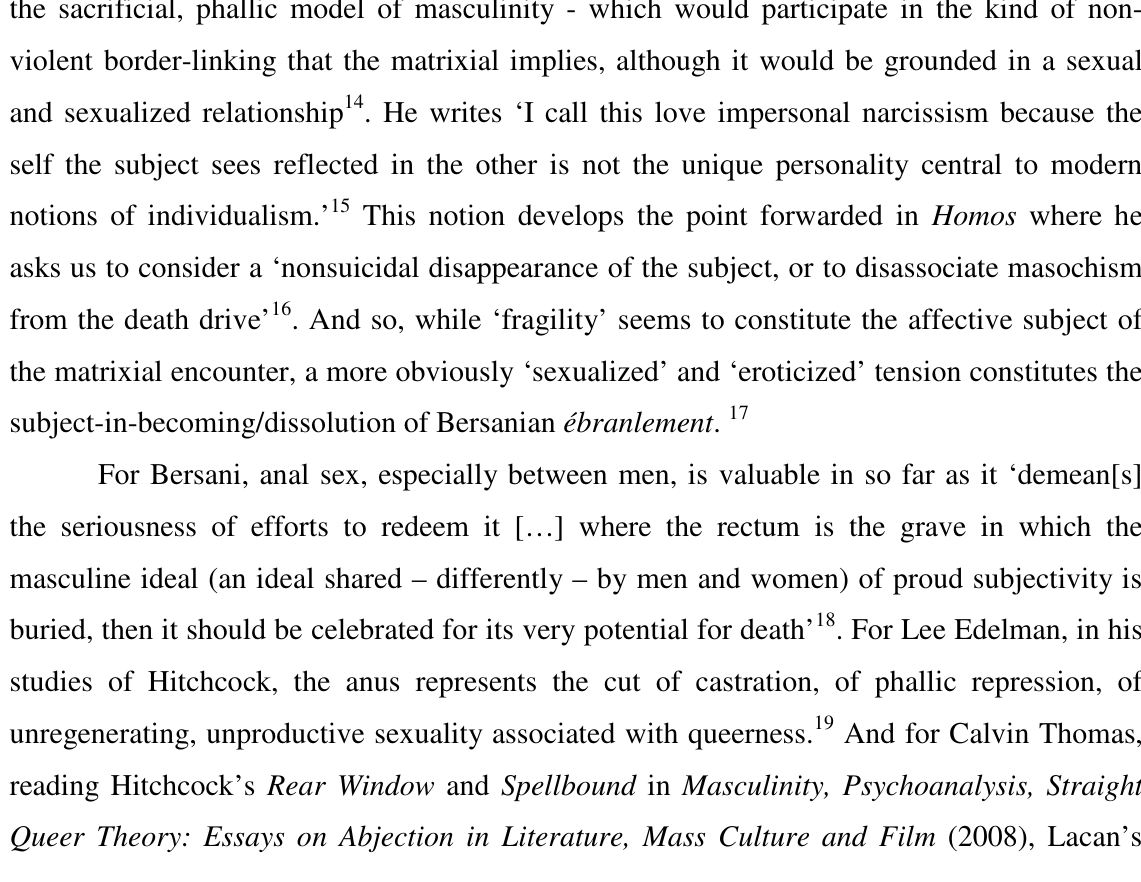
A view from Behind: Matrixiality, Masculinity, Queer Theory Studies in The Maternal, 1 (2) 2009,